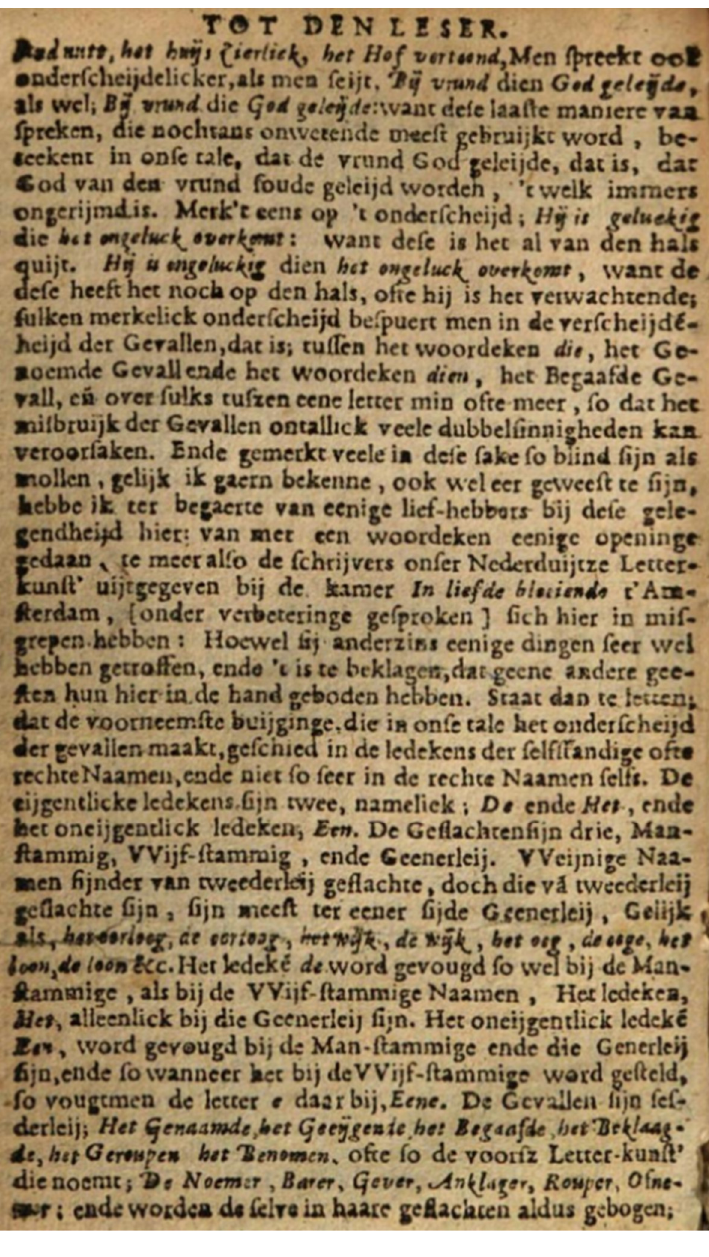
Figure 1. De Hubert (1624). Voorrede & Noodige waarschouwinge aan alle liefhebbers der Nederduijtze tale. In De psalmen des Propheeten Davids . Leiden: Pieter Muller, p. *6v (via GoogleBooks).